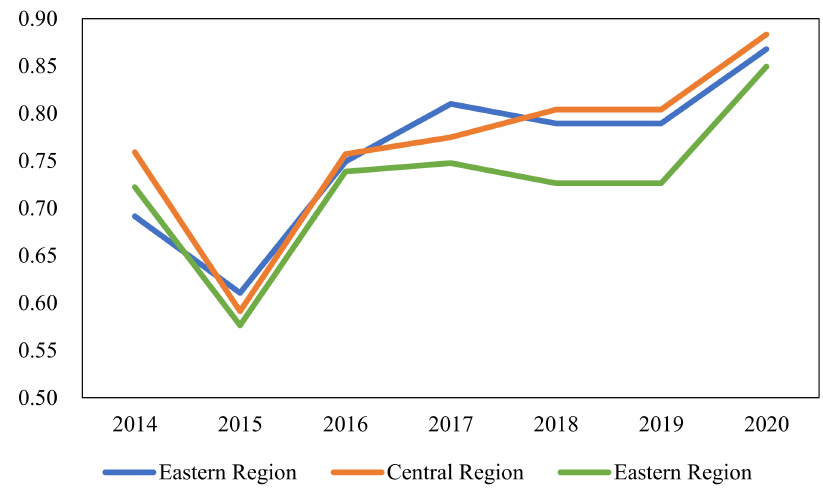
Figure 2. Financing efficiency value by areas.